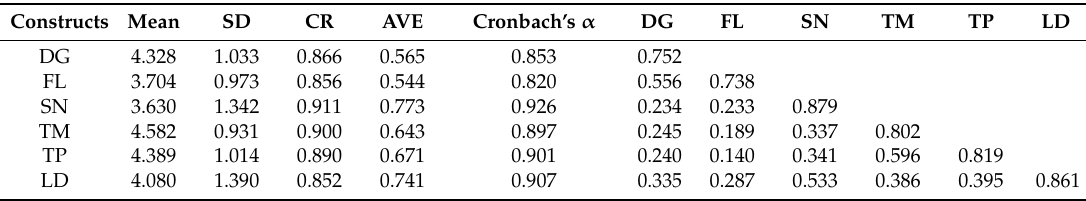
Table 2. Descriptive statistics, reliabilities, and correlations.